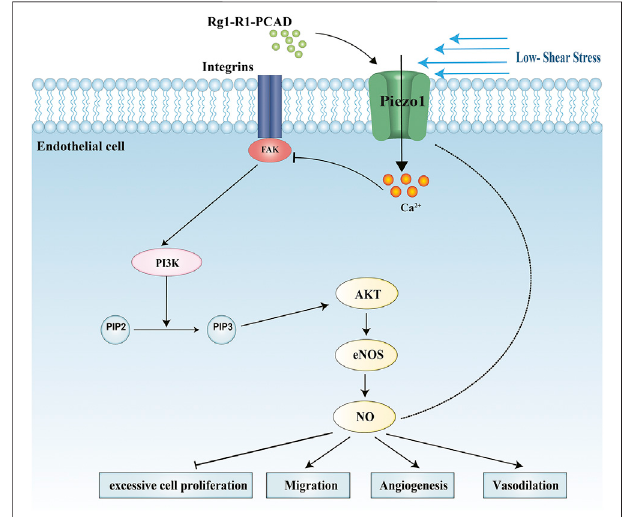
FIGURE 1 | Schematic model of the protective effects of RRP on endothelial cells against low- fl uid shear stress-induced